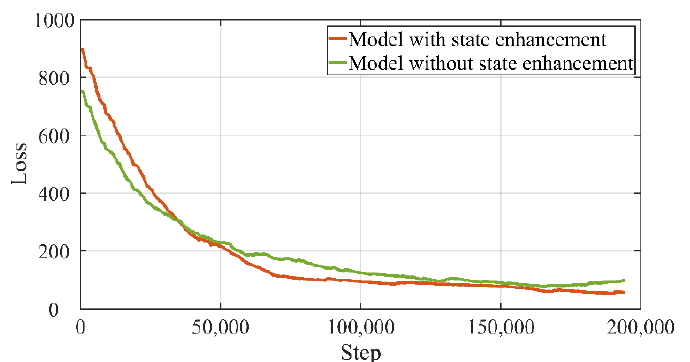
Figure 6. The training process and loss comparison of the learning from demonstration.